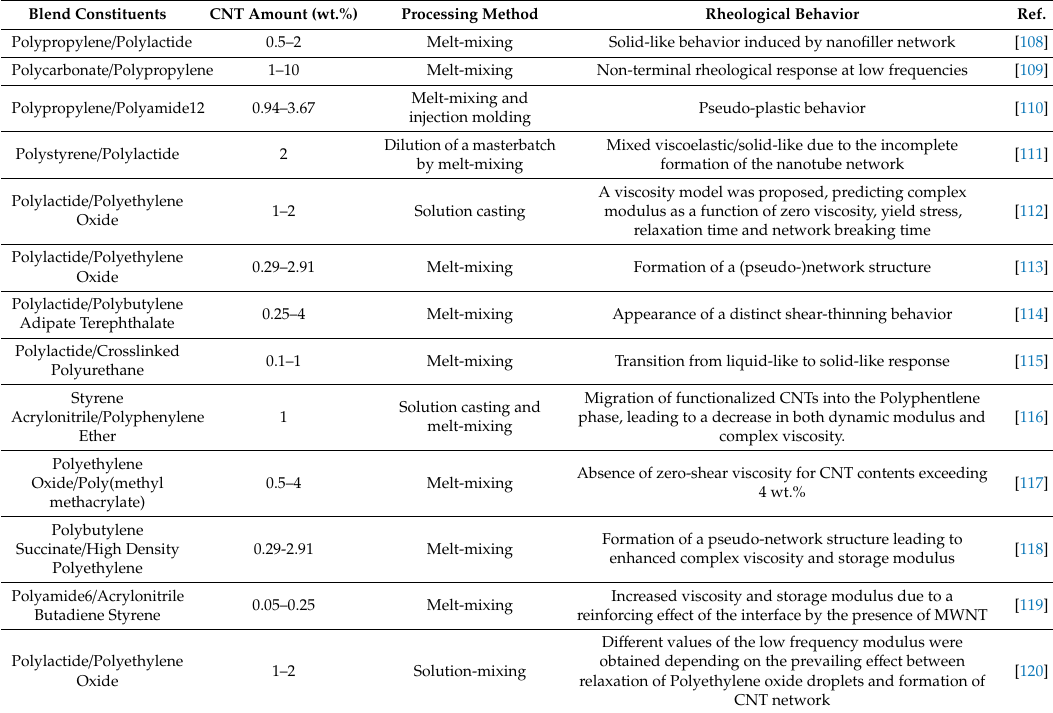
Table 1. Main rheological results for CNT-containing polymer